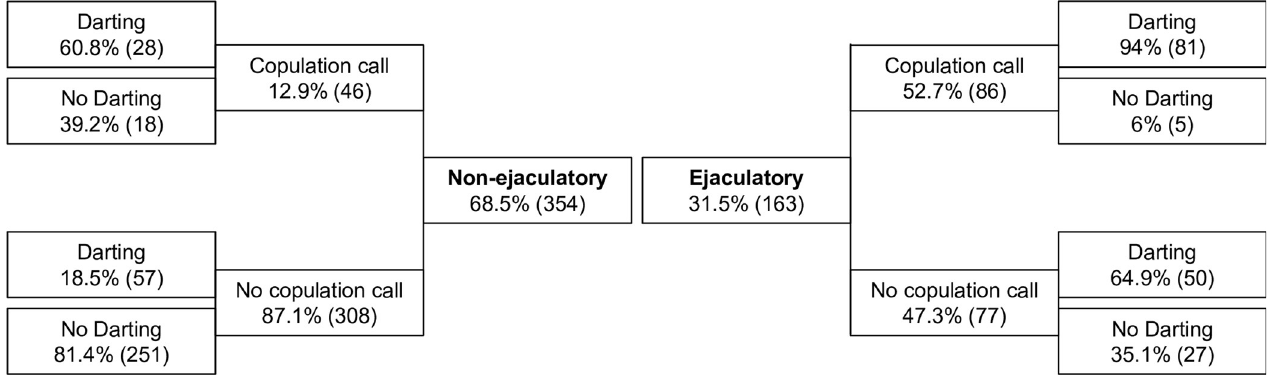
Fig 3. Frequency of copulation calls and darting. Frequencies are divided between ejaculatory copulations (right; N = 163) and non-ejaculatory copulations (left; N = 354). Total number of copulations (N = 517).